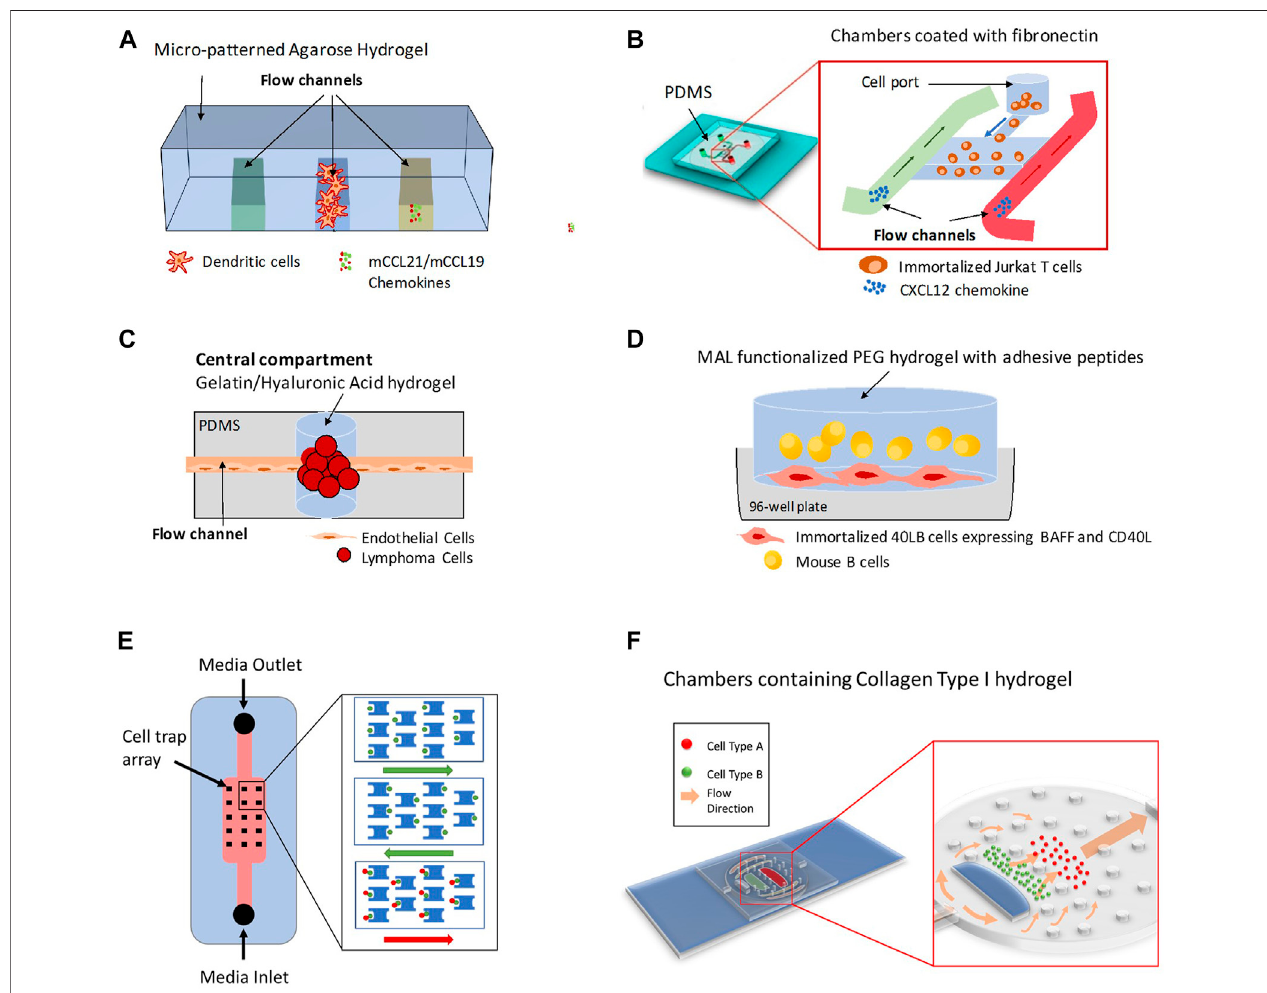
FIGURE 2| Different 3D Lymph Node-on-chip Models. (A) Model for 3D chemotaxis studies by (Haessler et al., 2009).It consists ofthree channels that produce a chemotactic gradient across the central channel, which is populated by Dendritic cells (DCs). (B) Model for fl ow-free chemokine gradient establishment and T cell migration analysis by (Sonmez et al., 2020). It consists of two fl ow channels and one microchamber. (C) Lymphoma-on-chip model for recreating the in-vivo like interactions between immune cells and tumors by (Mannino et al., 2017). The chip consists of a Polydimethylsiloxane (PDMS) structure that houses a hydrogel tumor model and that is traversed by an endothelialized channel. (D) Model for replicating germinal center formation, B cell differentiation and class switching recombination ex-vivo by (Béguelin et al., 2017; Purwada et al., 2019; Graney et al., 2020). It consists of Maleimide (MAL) functionalized poly (ethylene glycol) (PEG) immunetissue modelwithsuspended B-cellsand adherent40LB cellsinamicrowellplate. (E) Modelforquantitativepro fi lingand imagingoflymphocyteinteractions by (Dura et al., 2015). It consists of weir-based PDMS cellular traps. (F) Model for 3D co-culture of multiple cell types and for investigations of immune cell-cell interactions and immune-drug interactions by (Shanti et al., 2020; Hallfors et al., 2021). It consists of an elliptical body with multiple compartments formed by PDMS micropillars resemblingthedifferentcellularregionsofthenativelymphnode,aninletaperture resemblingtheafferentlymphaticvesselandanoutletaperture resemblingtheefferent lymphatic